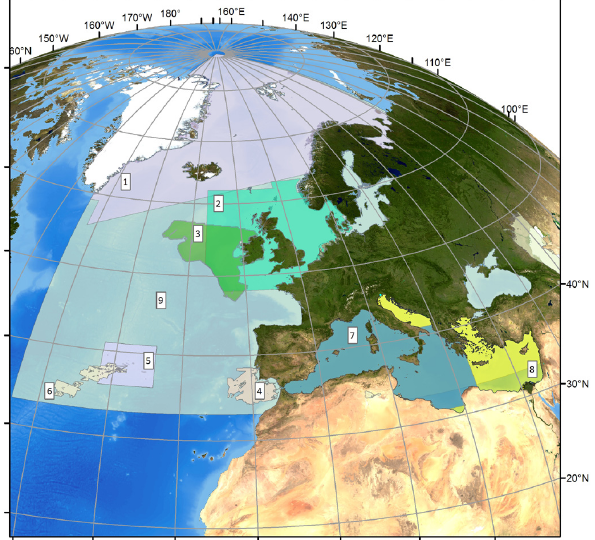
Fig. 2. Final map of the location of potential seamounts (black dots) in the OSPAR area ( n = 557) and in the Mediterranean Sea ( n = 101) as identified using multiple sources of bathymetry grids. Shaded layer shows the limits of the OSPAR